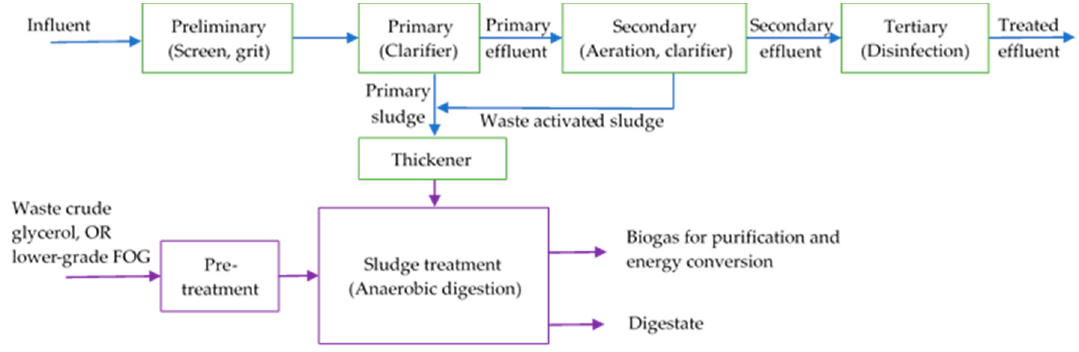
Figure 1. A suggested scheme for integrating anaerobic co-digestion of sewage sludge into a WWTP.